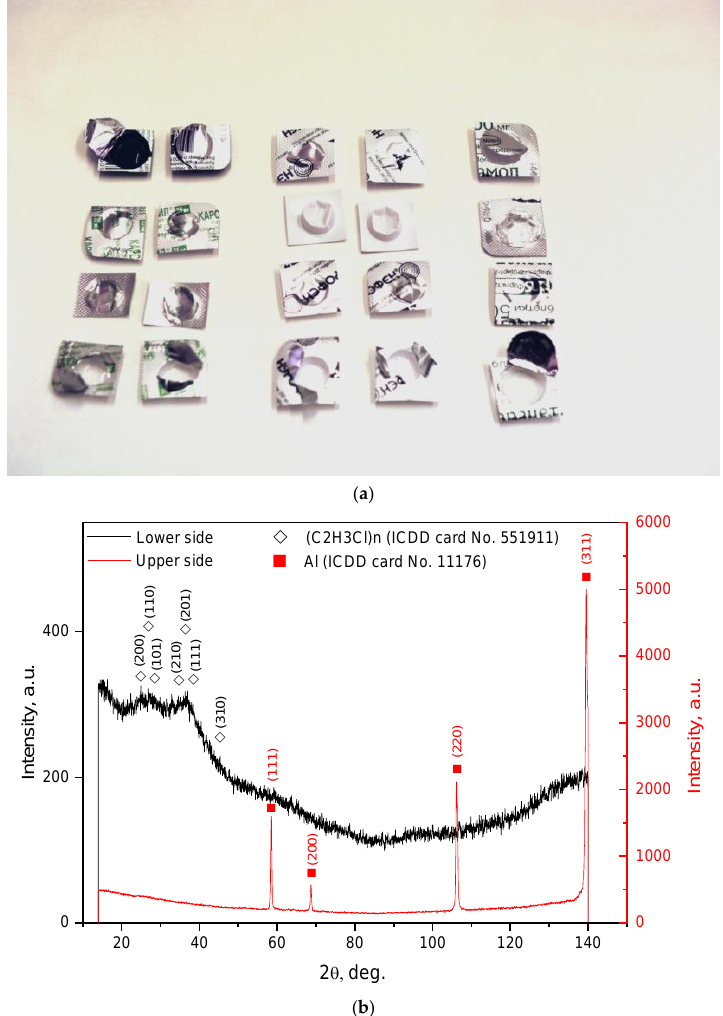
Figure 1. Characterization of a plastic–aluminum sample: ( a ) general view; ( b ) XRD patterns recorded from the lower (plastic) and upper (aluminum foil) sides.